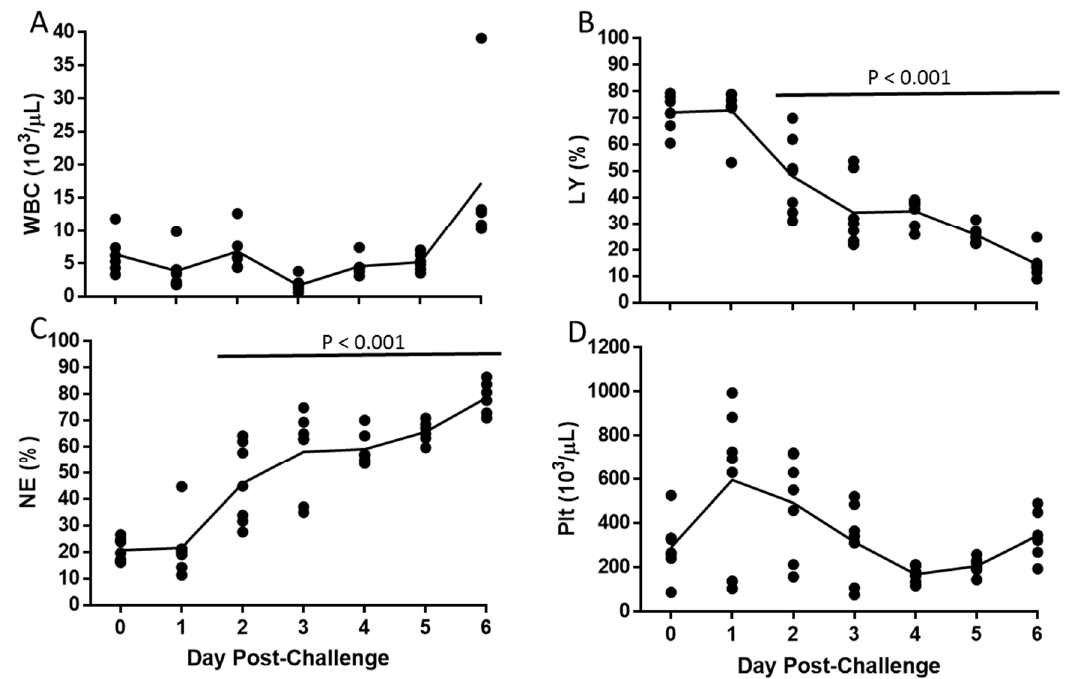
Figure 4. Hematological Changes following EBOV Challenge. Symbols ( • ) represent values for individual mice and the line represents means of White Blood Cell counts (WBC; A ), Percent of lymphocytes (LY; B ), Percent of neutrophils (NE; C ), and Platelet counts (Plt; D ). Horizontal bar indicates significant difference from Day 0.